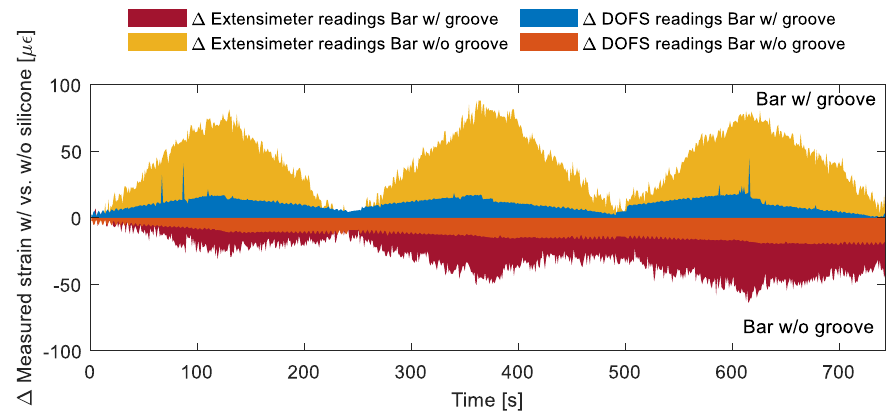
Figure 8. Bar w/groove and w/o groove’s strain reading differences when DOFS + cyanoacrylate (CYN) are or are not covered by silicone (SI).